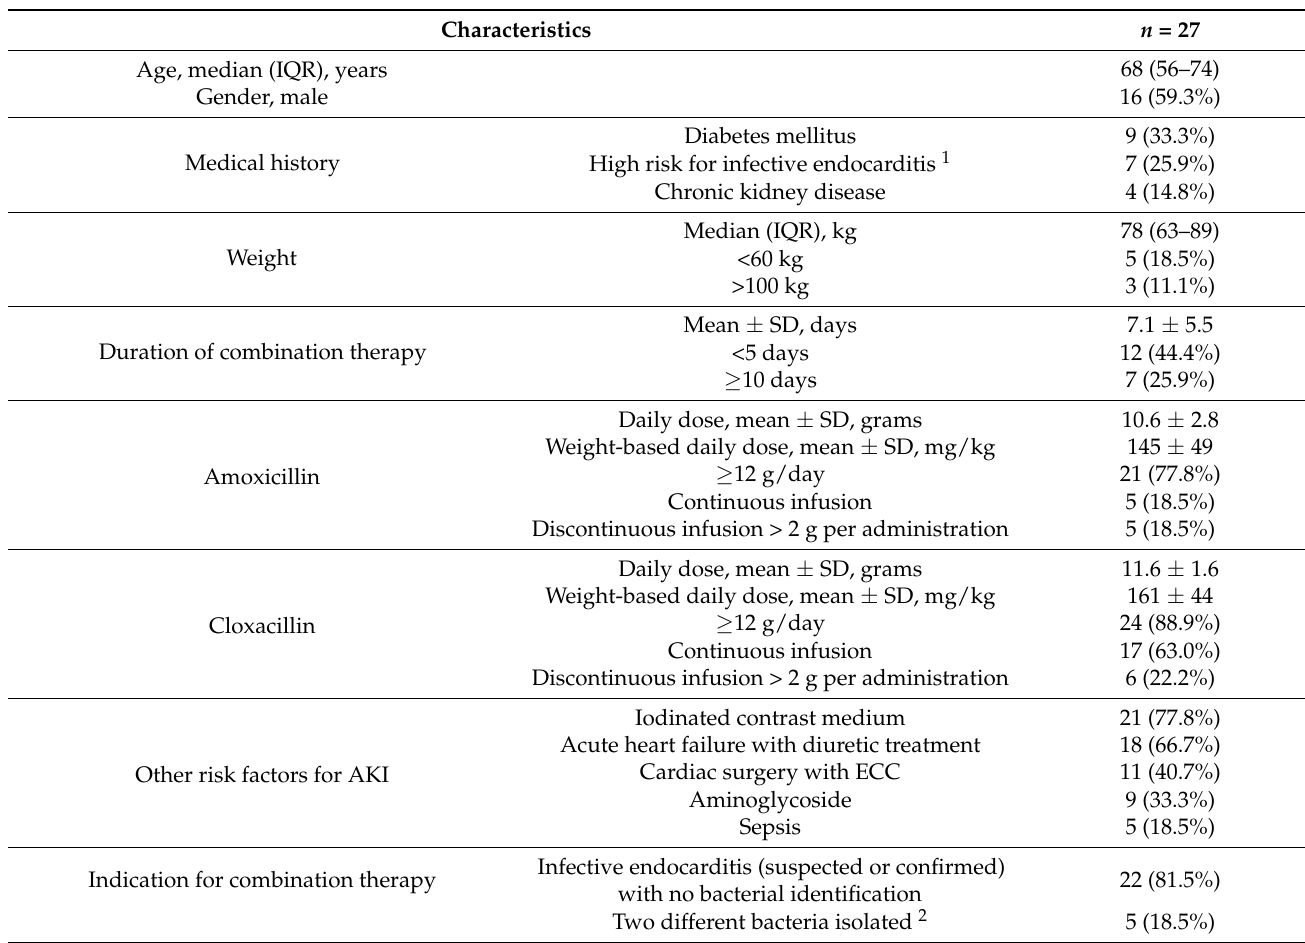
Table 1. Characteristics of patients treated with high-dose amoxicillin and cloxacillin combination.